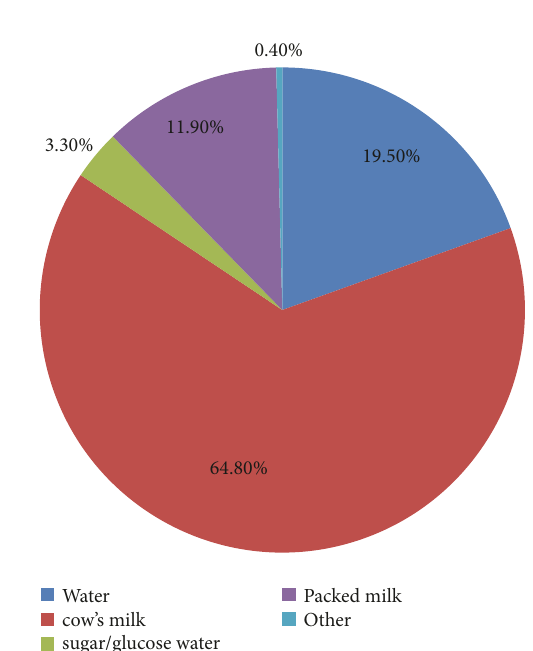
Figure 2: Knowledge of prelacteal feed given for neonate in Addis Ababa health centers, Dec. 1-Jan. 30, 2017.